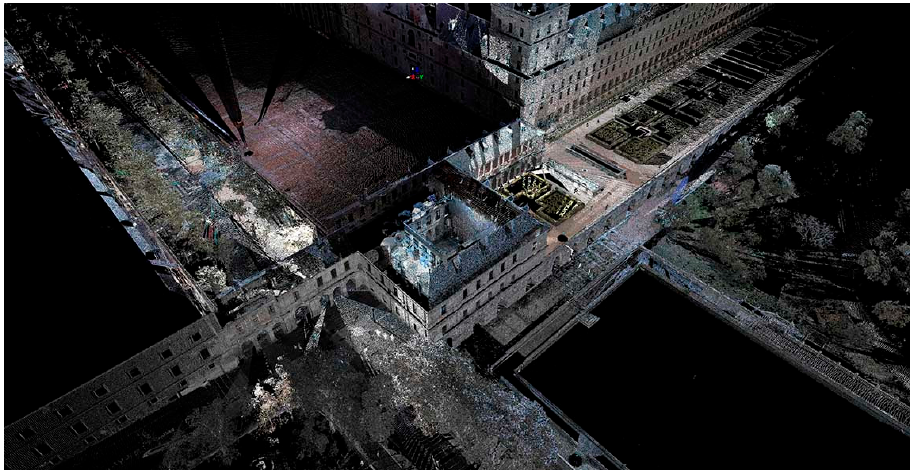
Figure 15. Aerial view of the generated 3D textured model of the area surrounding the Botica , after processing by the Leica Cyclone software (Cyclone 9.2, Leica Geosystems, Heerbrugg, Switzerland ).